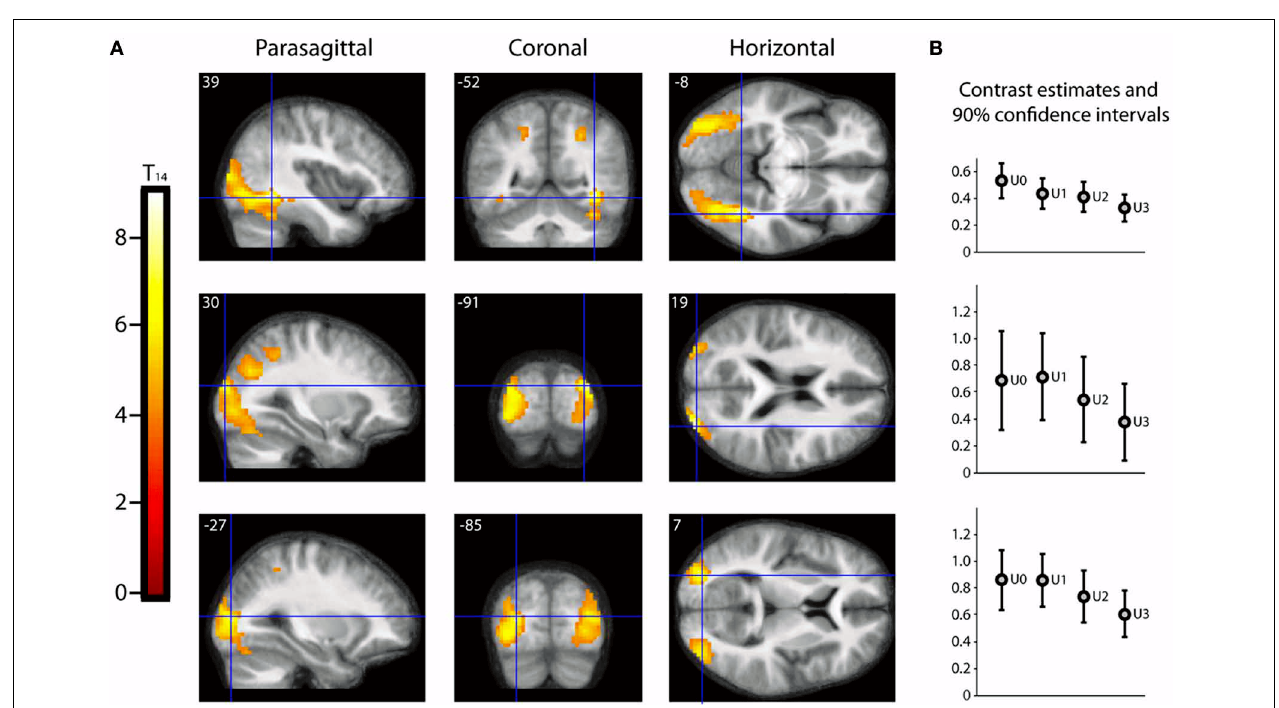
FIGURE 5 | Parametric “De-activations” with Understanding. (A) Second level parametric analysis derived from 15 subjects, to show parametric modulation by understanding rating (after orthogonalization to scan-time beauty rating). One-sample t -test ( df = 14) thresholded at P unc < 0 . 001 with an extent threshold of 10 voxels, revealed two peak “de-activations” significant ( P FWE < 0.05 ) with familywise error correction over the whole brain volume, at (39, − 52, − 8) ( T 14 = 9 . 01, P FWE = 0 . 010) and at (30, − 91, 19) ( T 14 = 8 . 05, P FWE = 0 . 032). A third peak at ( − 27, − 85, 7) ( T 14 = 7 . 65, P FWE = 0 . 050) was just above threshold. The location of each peak is